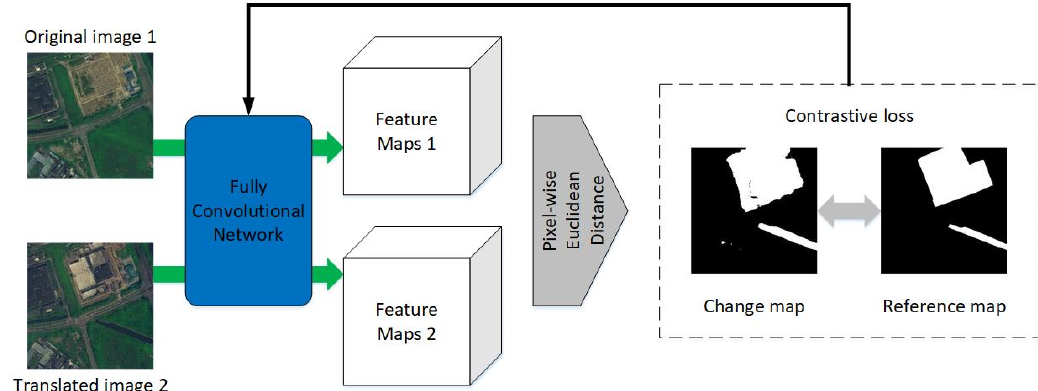
Figure 3. Dataflow of the Siamese detector. The changed pixels are white, while the unchanged pixels are black.